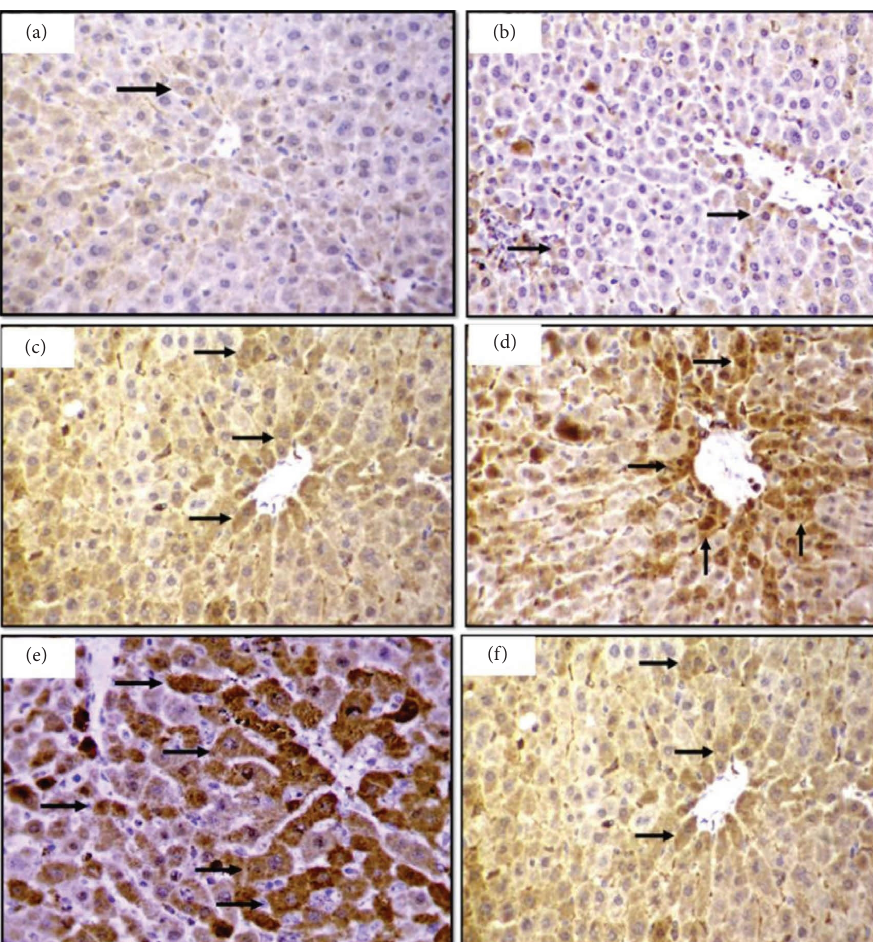
Figure 3: Liver section in mice showing immunohistochemical staining method detection of metallothionein (MT) stained positive cells. (a) Te control group showing a few positive cells. (b) Treated with ZnCl 2 10mg/k showing a slightly positive increased. (c) Treated with CdCl 2 1.5mg/k. (d) Treated with ZnCl 2 10+CdCl 2 1.5 mg/k, the positive cells are notably increased. (e) Treated with CdCl 2 3mg/k. (f) Treated with